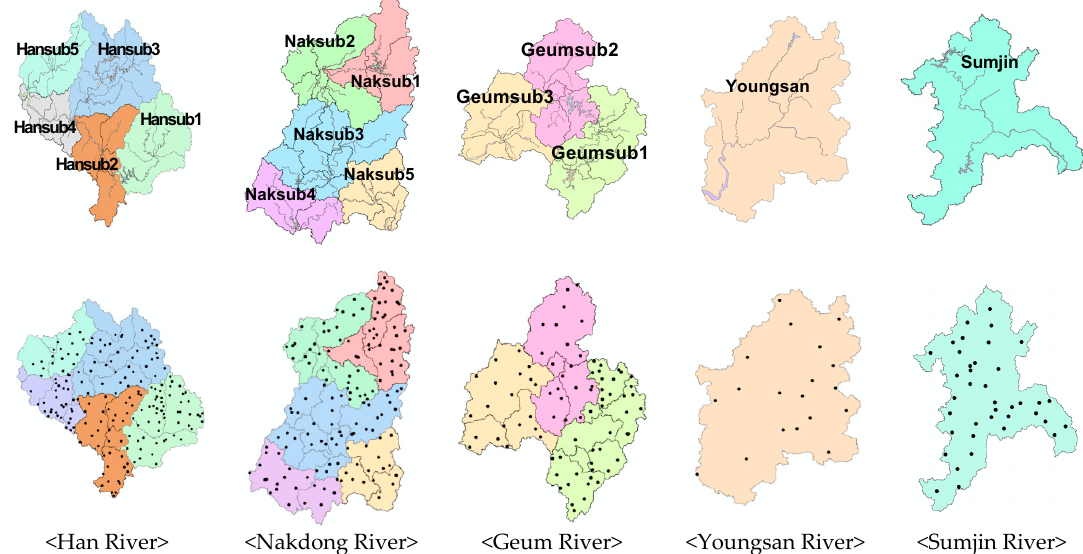
Figure 2. Installed Rain Gauges in Each Sub-basin of the Five Large Basins.